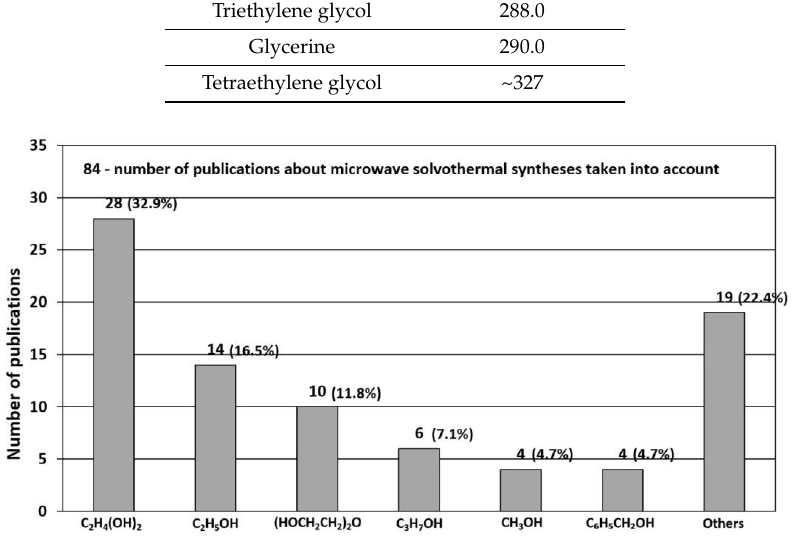
Figure 35. Statistics of use of various organic solvents in the microwave solvothermal synthesis. Source: [402,573,758–838].